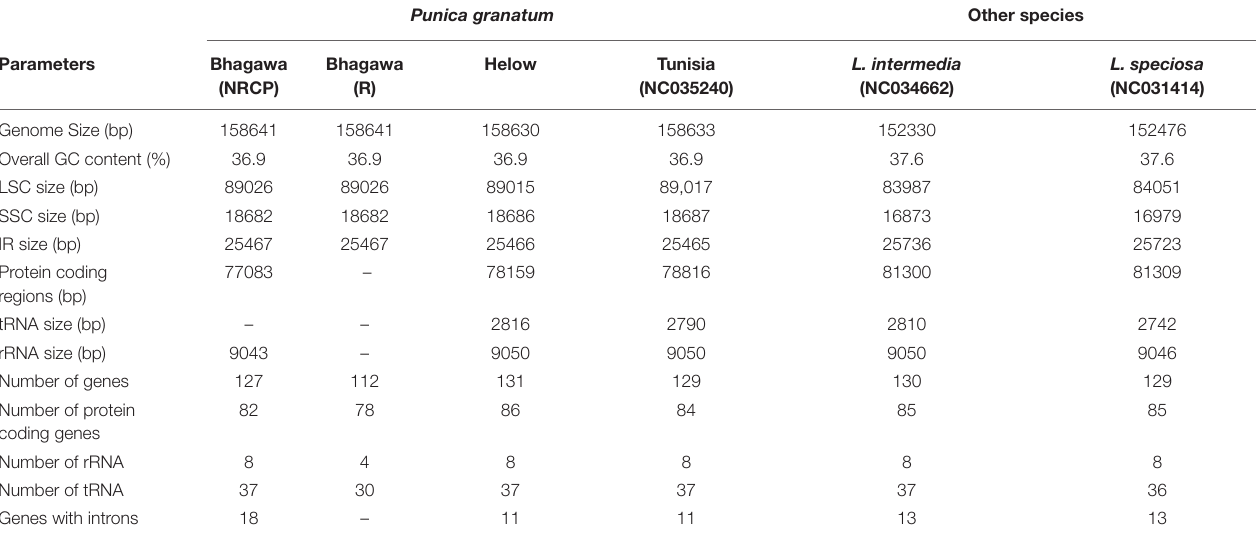
TABLE 4 | Comparison of the “Bhagawa (NRCP)” chloroplast genome with other genotypes.